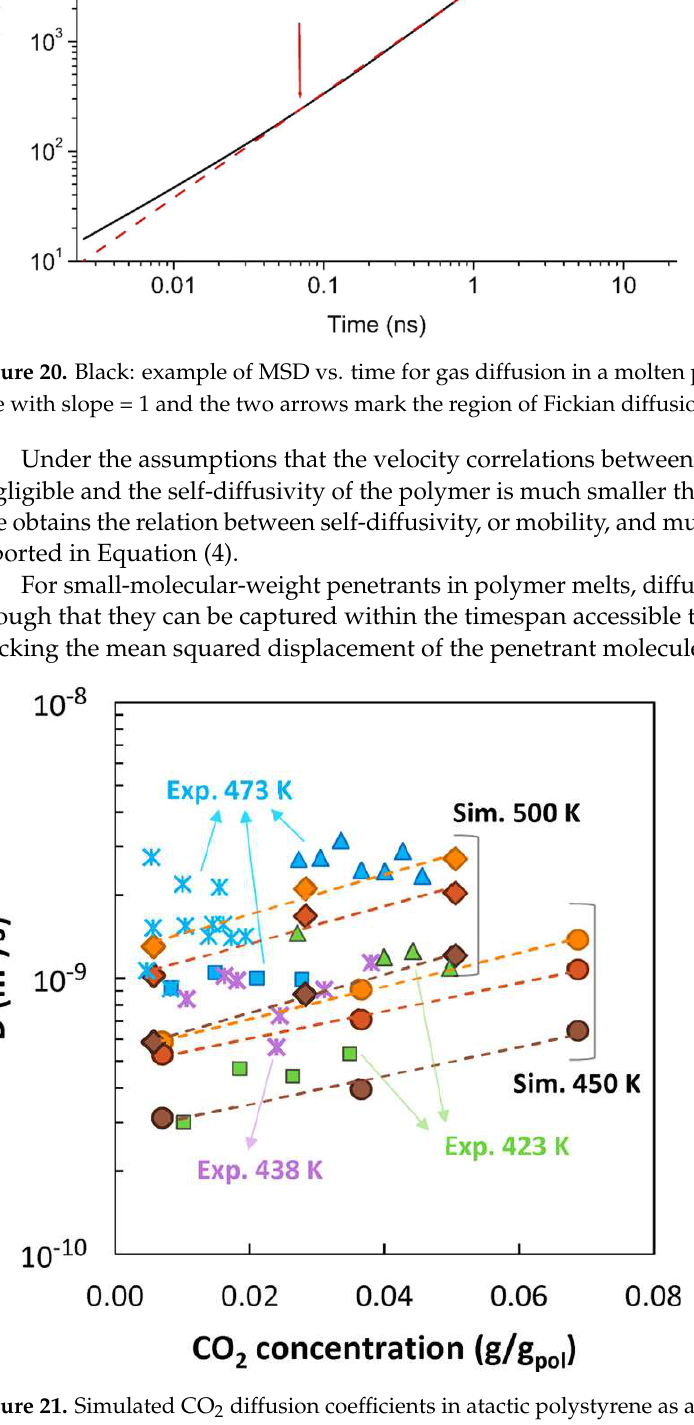
Figure 20. Black: example of MSD vs. time for gas diffusion in a molten polymer. Red: the dashed line with slope = 1 and the two arrows mark the region of Fickian diffusion.